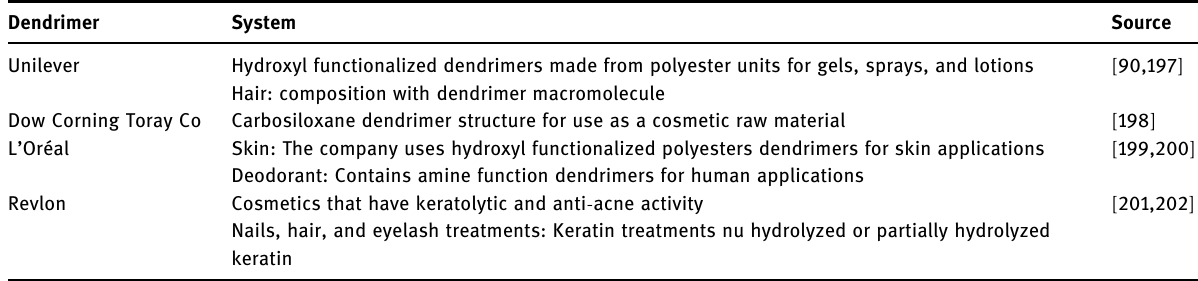
Table 9: Commercial uses of dendrimers